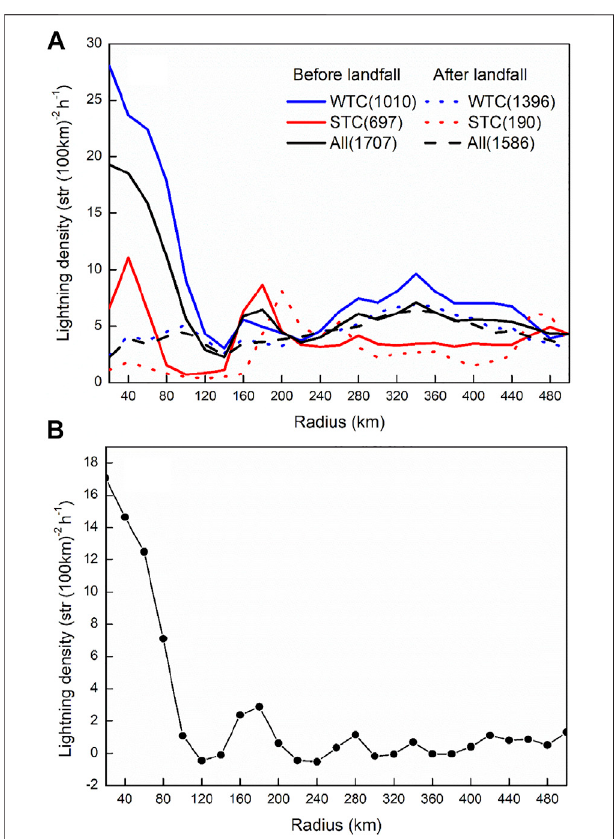
FIGURE5| Radialdistributionof (A) lightningdensity(str(100 km) − 2 h − 1 ) for weak (TD\TS\STS) and strong (TY/STY/SuperTY) TCs 24 h before and after landfall, and (B) lightning density before landfall minus after